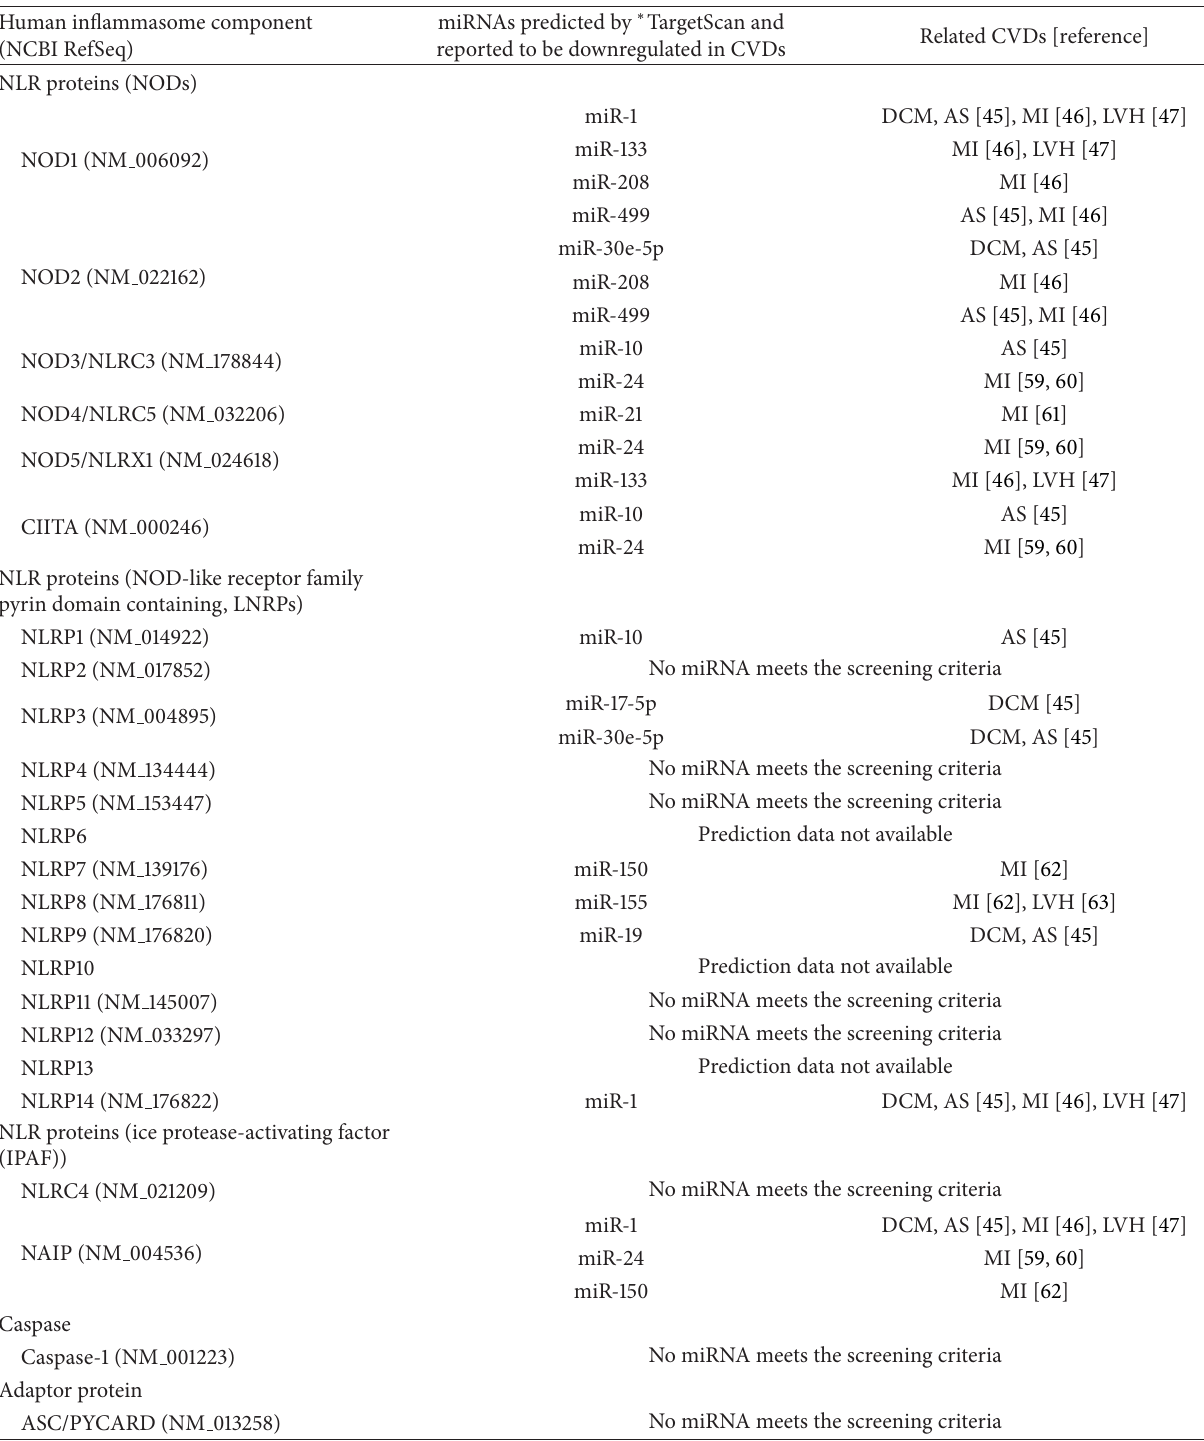
Table 1: Examples of miRNA downregulated in CVDs with potential connection on